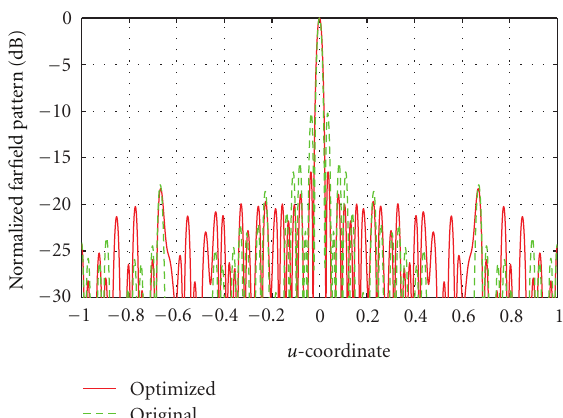
Figure 12: Principal u -cut radiation pattern for the second